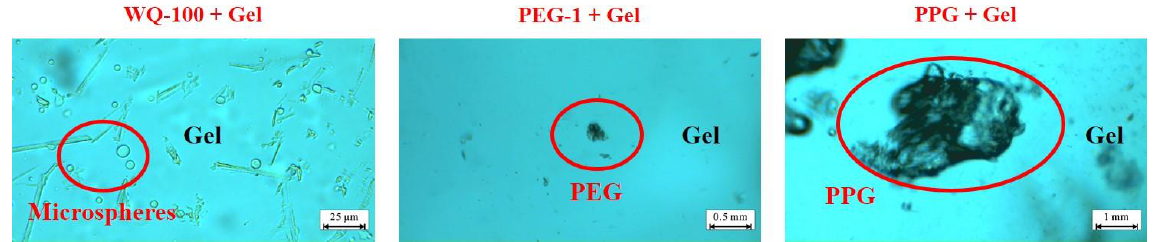
Figure 10. Micrograph of enhanced gels systems.